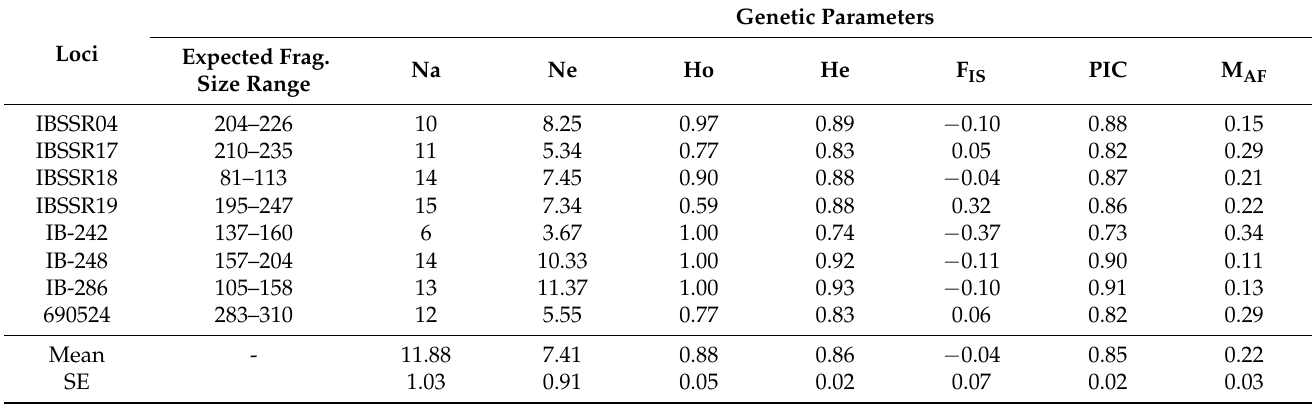
Table 3. Genetic parameters describing the diversity among 31 sweetpotato genotypes based on 8 polymorphic SSR markers.